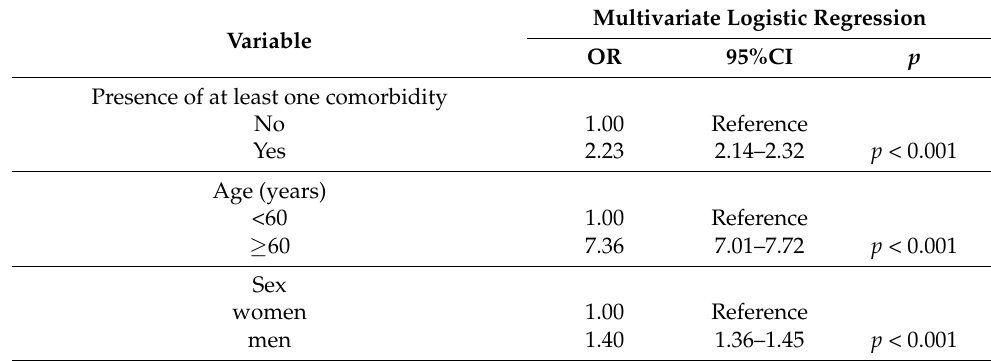
Table 3. The impact of comorbidities on COVID 19–related risk of in-hospital death controlled for the age and